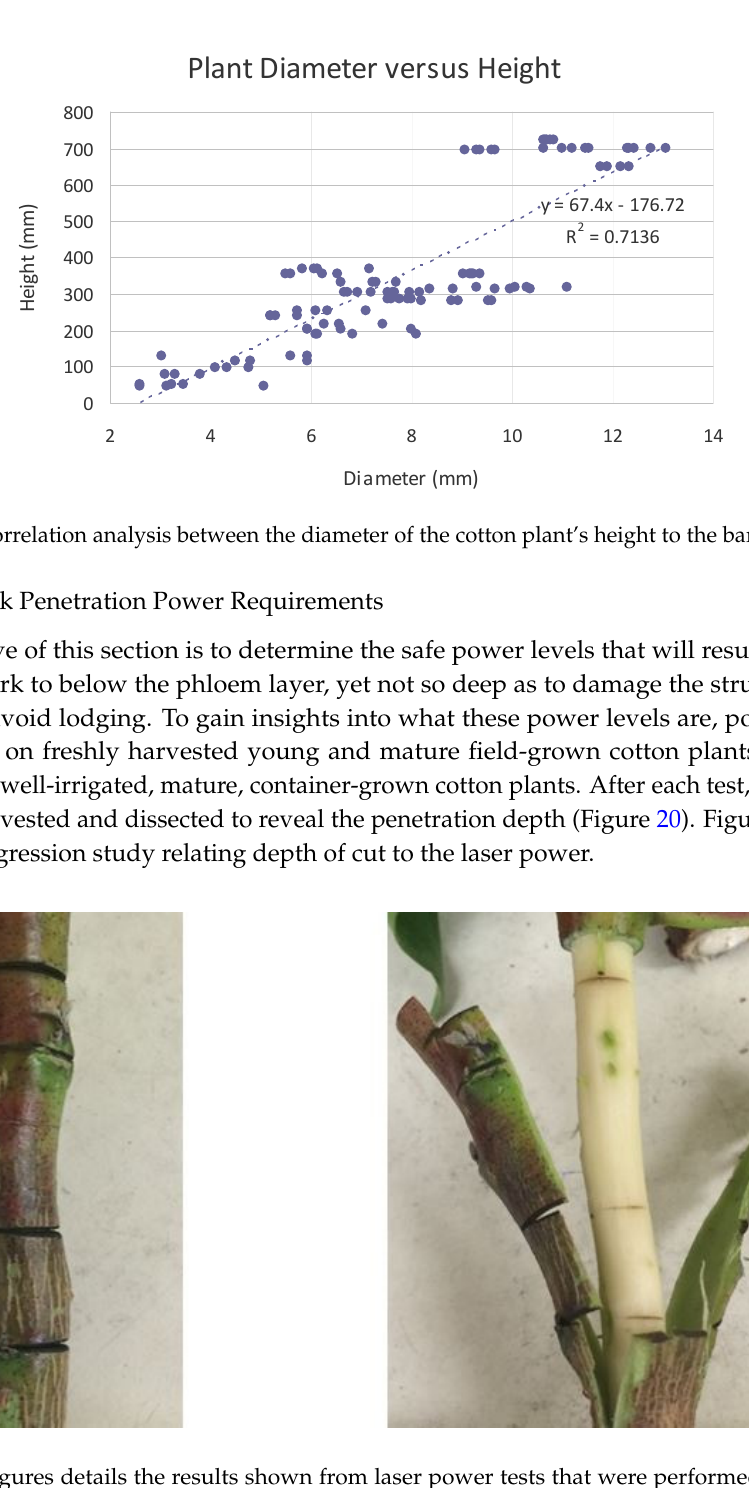
Figure 18. Correlation analysis between the diameter of the cotton plant’s main stalk to the bark thickness.